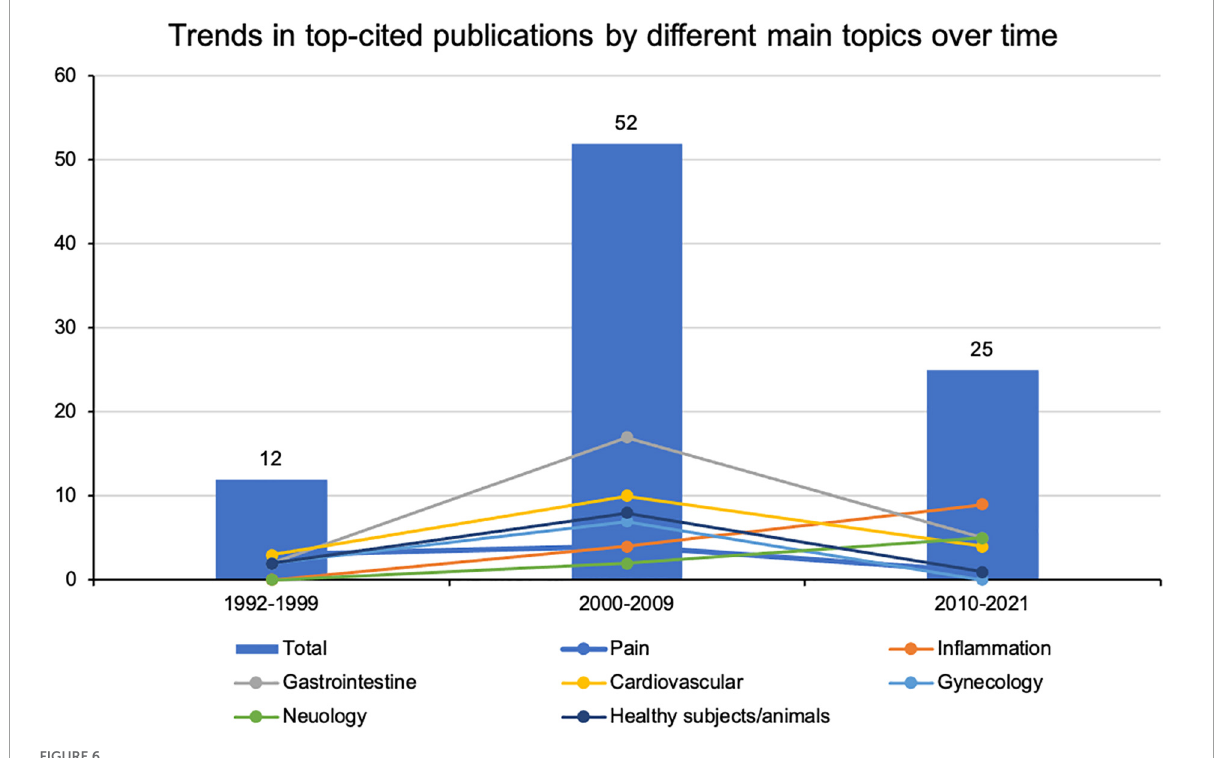
FIGURE6 Trends in top-cited publications by different main topics over